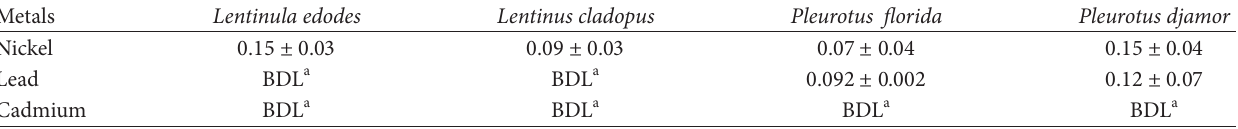
T 3: Toxic metal concentrations (mg/100g on dry weight basis) in four species of